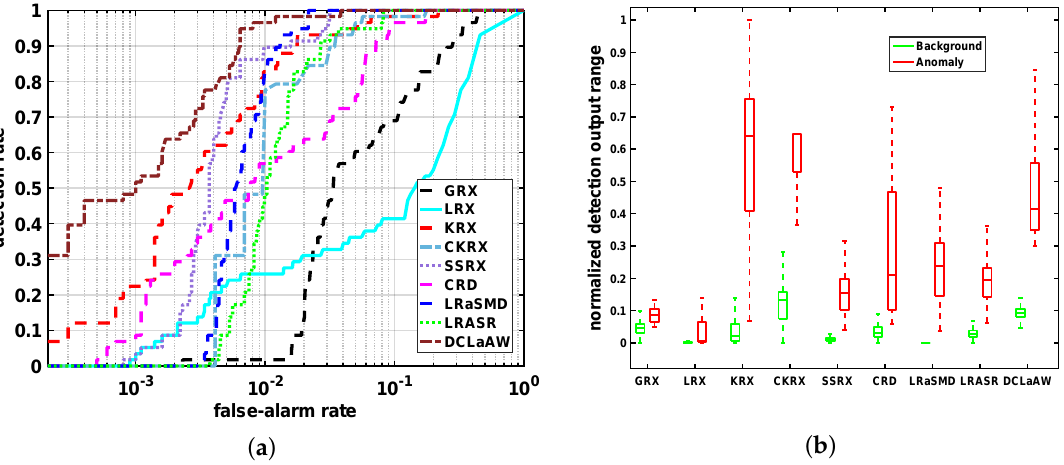
Figure 16. Quantitative comparisons of all compared algorithms for the San Diego dataset. ( a ) ROC curves; ( b ) Background-anomaly separation